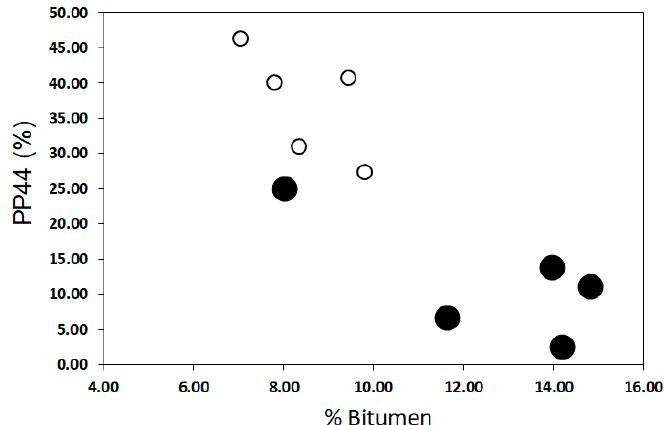
Figure 5. Froth color as a qualitative metric in relation to %bitumen (x axis) and pp44 (y axis) in ore. Black and larger circles = dark froths. Smaller circles = brown froths.